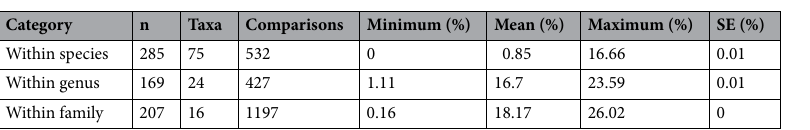
Table 2. K2P divergence values from 350 analysed specimens with increasing taxonomic levels. SE standard error.